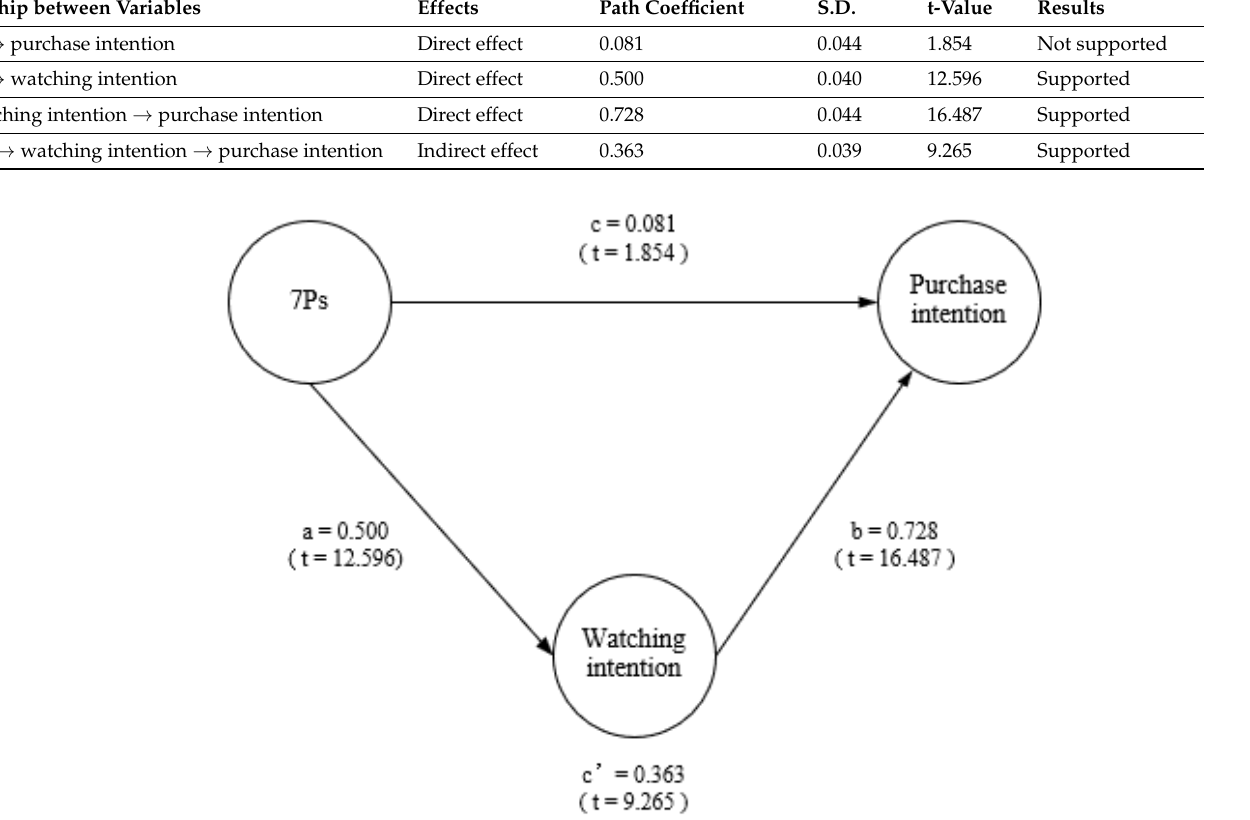
Figure 5. The role of watching intention as a mediating